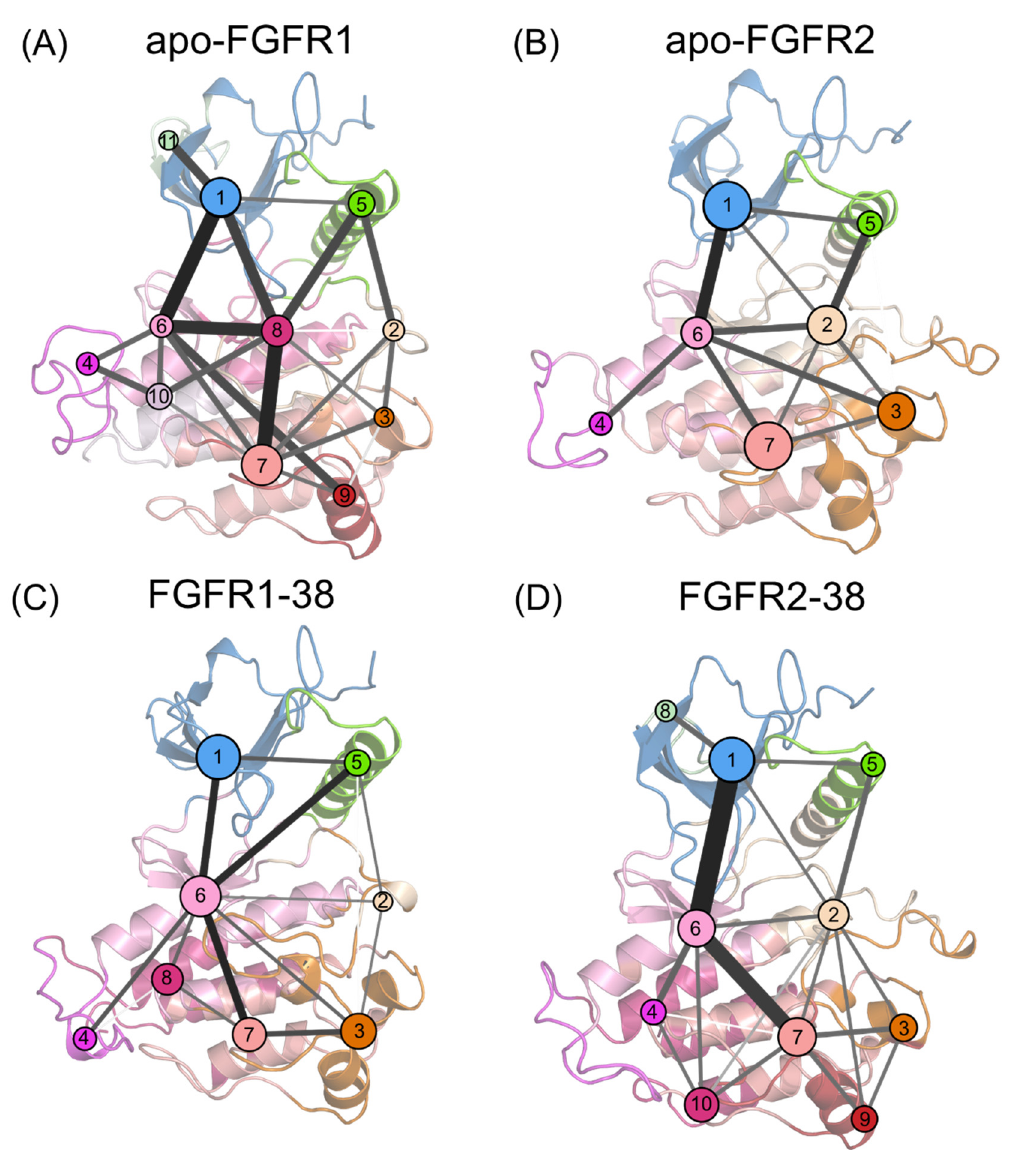
Figure 7. Community networks superimposed on the 2D structure of the apo-FGFR1 ( A ), apo-FGFR2 ( B ), FGFR1-38 ( C ), and FGFR2-38 ( D ) systems. Each circle represents an individual community. The size of the circle is proportional to the number of residues in each community, while the widths and colors of the lines connecting communities represent the corresponding intercommunity